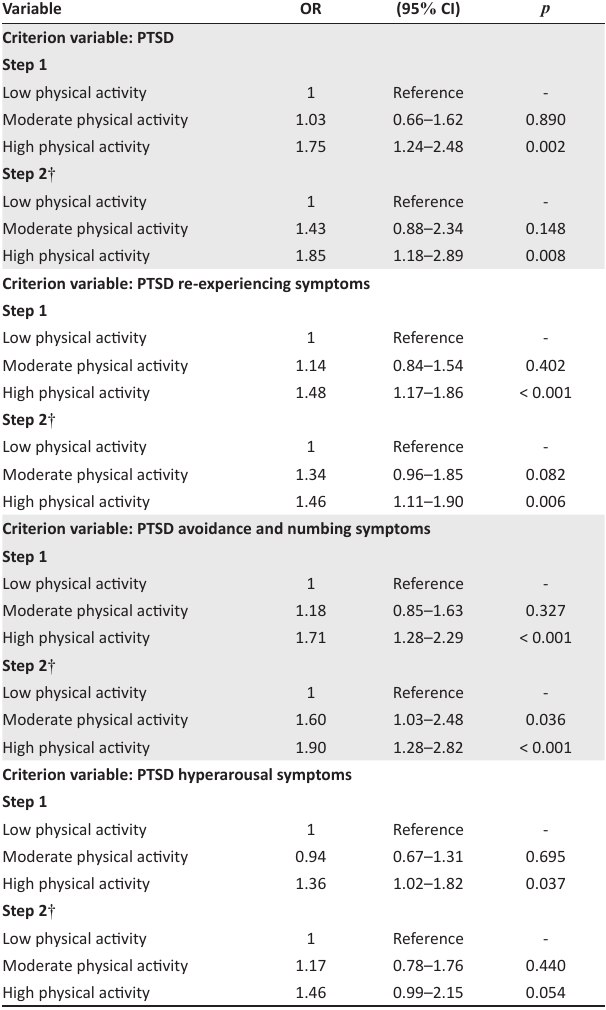
TABLE 2: Associations between physical activity levels and PTSD ( N =